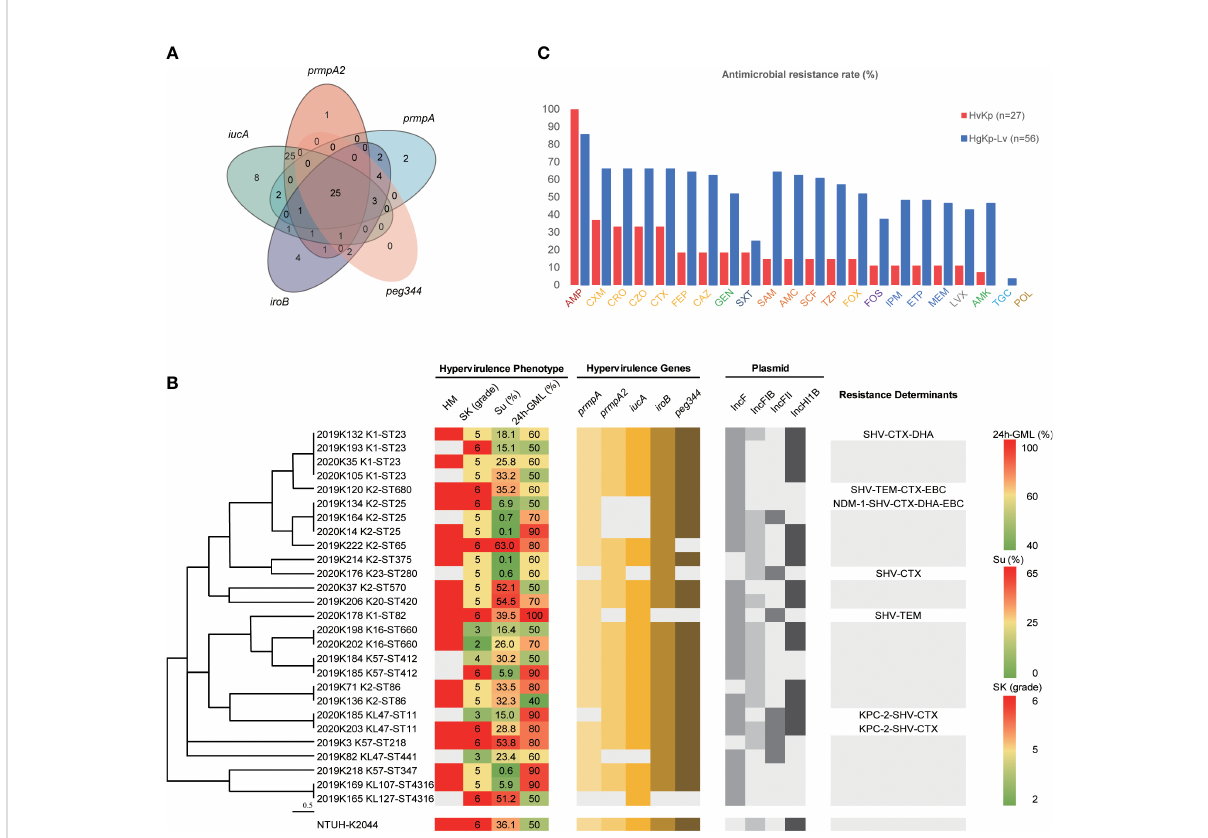
FIGURE 2 Features of hypervirulent K pneumoniae strains. (A) Distribution of hypervirulence genes among hgKp isolates (n = 83). (B) Hypervirulence genes, hypervirulence phenotypes, plasmid types, and resistance genes of hvKp isolates (n = 27) with various capsule K serotypes and sequence types. Phylogenetic relationships were analyzed by Phyloviz 2.0 software using hierarchical clustering based on the genetic distance of sequence types. HM, hypermucoviscous phenotype; SK, serum resistance; SP, siderophore production; 24h-GML, 24-hour lethality in G mellonella infection model. Resistance determinants without text meant no other genes carried except bla SHV (intrinsic resistance for K pneumoniae ). (C) Antimicrobial resistance rates of hvKp (n = 27) and hgKp-Lv (n = 56). AMP, ampicillin; CXM, cefuroxime; CRO, ceftriaxone; CZO, cefazolin; CTX, cefotaxime; GEN, gentamicin; FEP, cefepime; CAZ, ceftazidime; SXT, trimethoprim-sulfamethoxazole; FOX, cefoxitin; SAM, ampicillin-sulbactam; TZP, piperacillin-tazobactam; AMC, amoxicillin-clavulanic acid; SCF, cefoperazone-sulbactam; FOS, fosfomycin; LVX, levo fl oxacin; IPM, imipenem; MEM, meropenem; ETP, ertapenem; AMK, amikacin; POL, polymyxin B; TGC, tigecycline. Antimicrobial agents labelled with the same color were grouped into a single antimicrobial category: AMP, Penicillins; CXM/CRO/CZO/CTX/FEP/CAZ/FOX, Cephems; GEN/AMK, Aminoglycosides; SXT, Folate pathway inhibitors; SAM/AMC/SCF/TZP, b lactam combination agents; FOS, Fosfomycins; IPM/ETP/ MEM, Carbapenems; LXT, Antipseudomonal fl uoroquinolones; TGC, Glycylcyclines; POL,